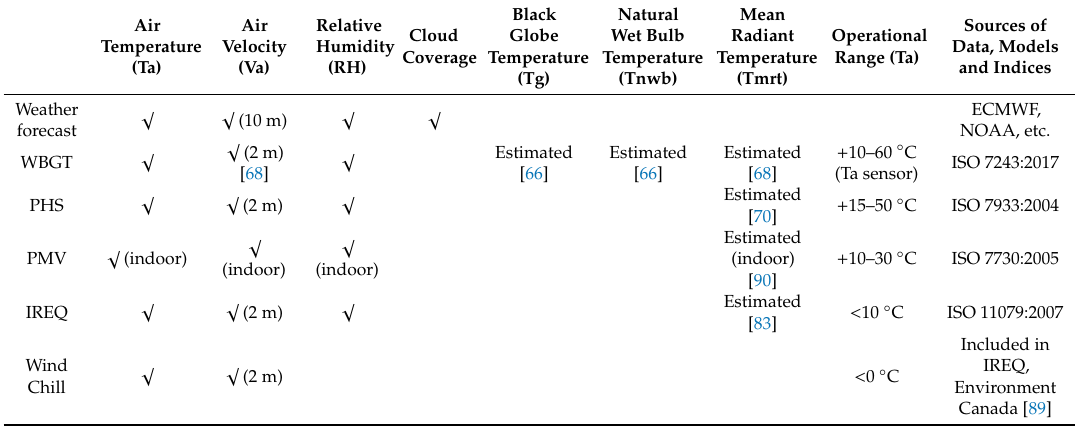
Table 1. Available weather forecast data and required input parameters for thermal indices and body heat balance models. The estimated mean radiant temperature (Tmrt) for all models and indices are based on previous literature